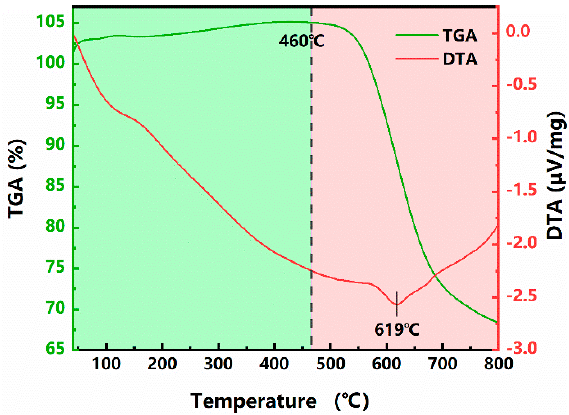
Figure 9. TGA and DTA curves of the ultra-thin PI film.